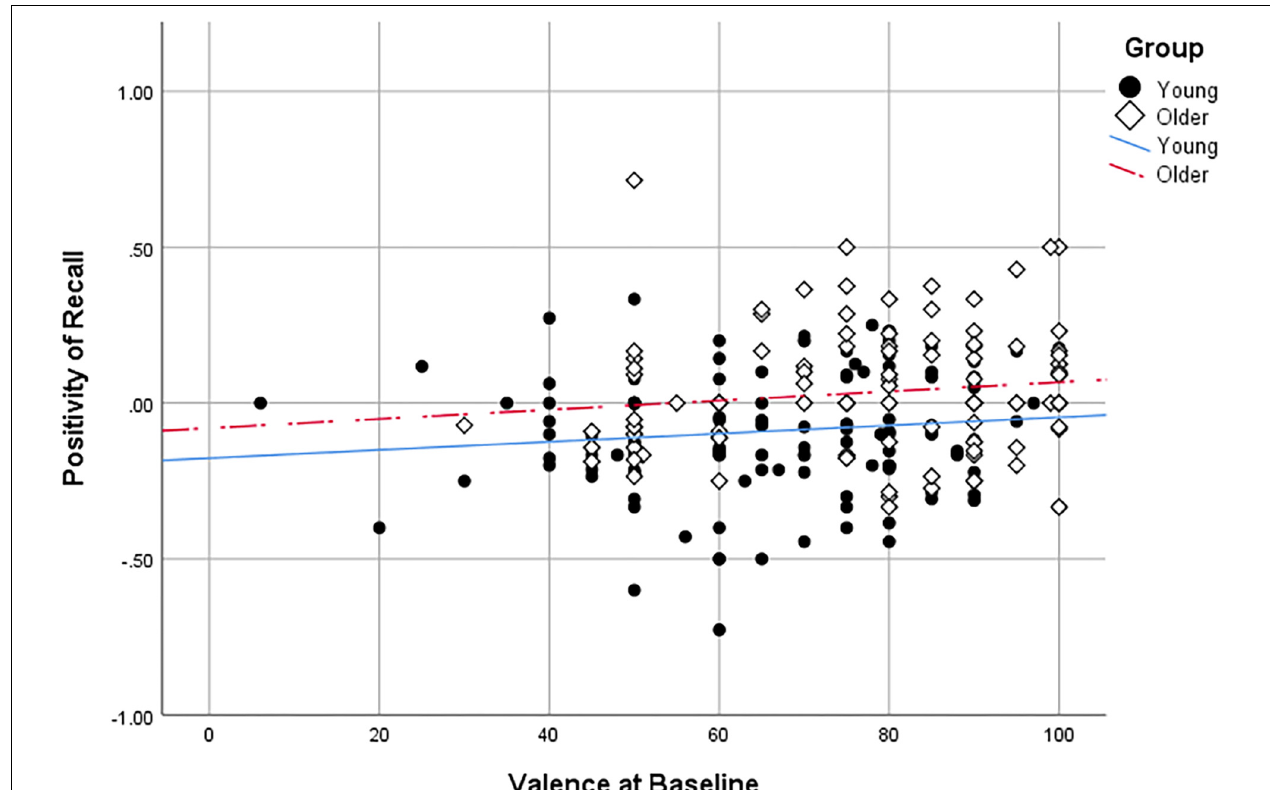
FIGURE 2 | Positivity of recall scores as a function of valence at baseline in young adults and older adults.